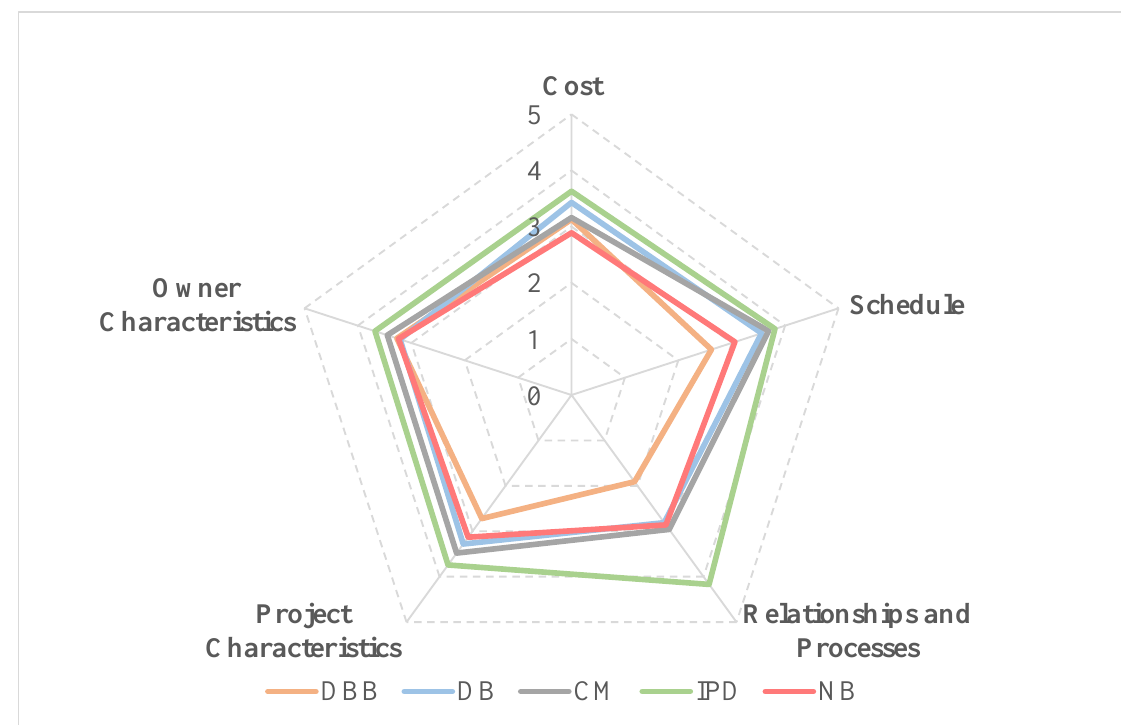
Figure 10. Average utilities of procurement approaches according to main criteria .